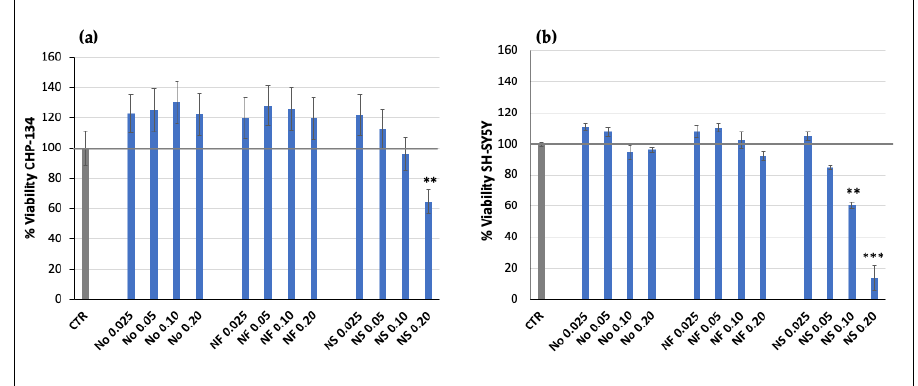
Figure 3. Relative viability of ( a ) CHP-134 and ( b ) SH-SY5Y cells treated with increasing concentrations of Nanofenretinide (NF) and Nanospermidine (NS) for 24 h in comparison with empty nanomicelles (No). Viability was evaluated by MTT assay and expressed as percentage versus control (100%) (mean ± SD, n = 6) (** p < 0.01, *** p < 0.001). Treatment with NX had a higher effect on CHP-134 than SH-SY5Y. Indeed in CHP- 134 NX, the cell viability decreased to about 48%, 39%, and 37% after 72 h at 5, 10, and 20